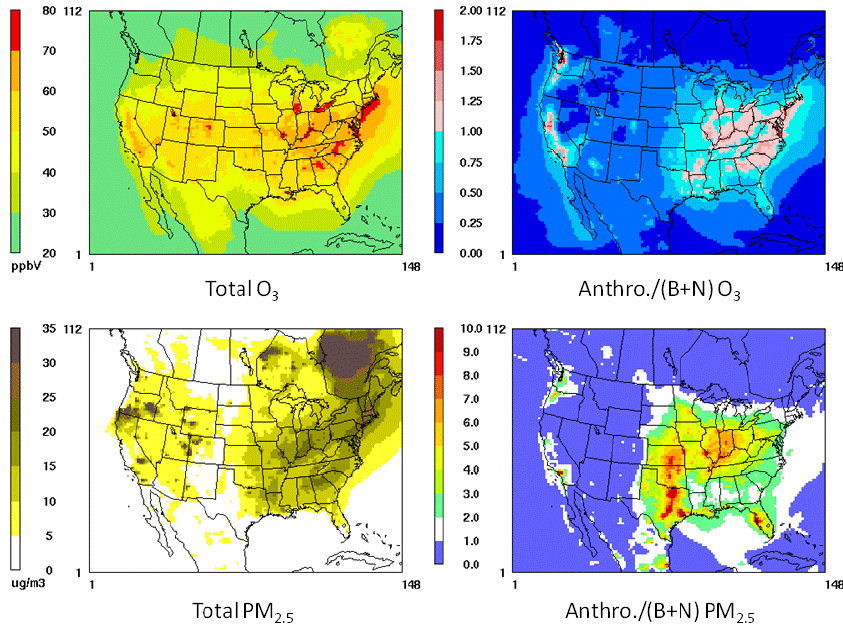
Fig. 11. Mean July 2002 simulated surface values representing total (natural and anthropogenic) maximum daily 8-h average O 3 (upper left), PM 2.5 (lower left), and the ratios of anthropogenic to background+natural (B+N) O 3 (upper right) and PM 2.5 (lower right).